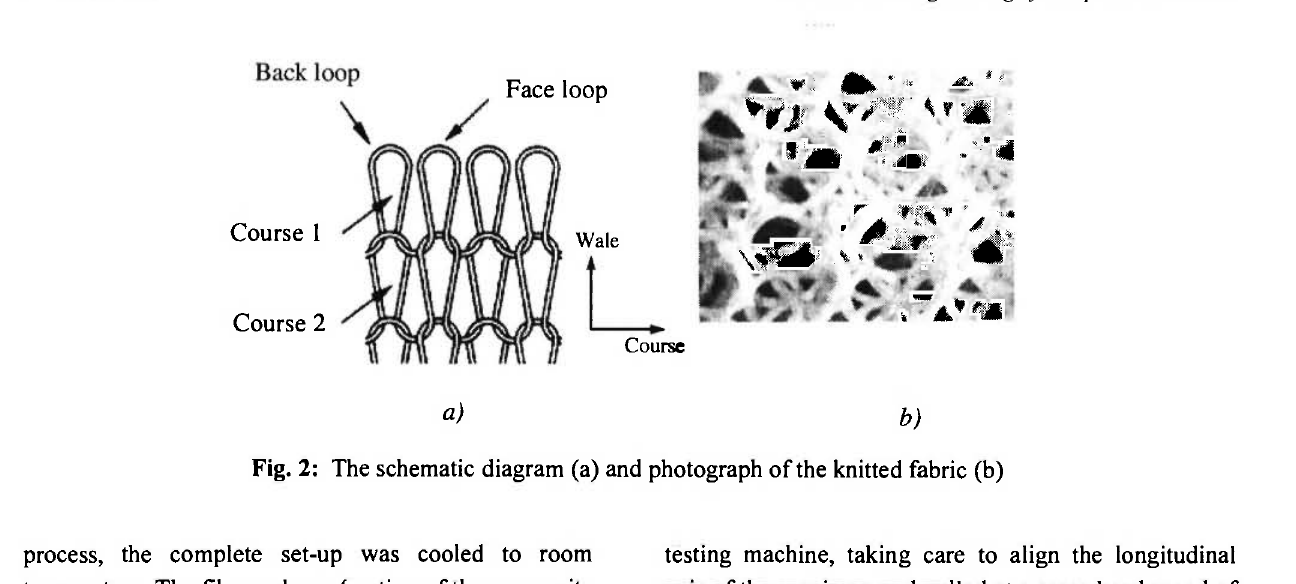
Fig. 2: The schematic diagram (a) and photograph of the knitted fabric (b)